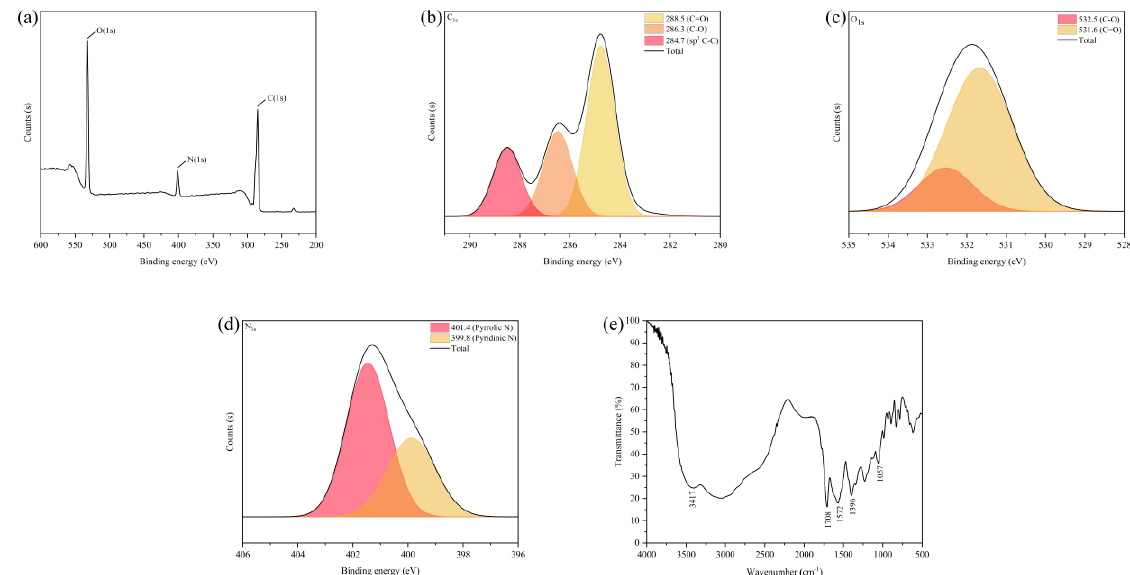
Figure 2. ( a ) XPS scanning spectrum of CDs. ( b ) C 1S , ( c ) O 1S , ( d ) N 1S XPS spectra of CDs. ( e ) FT-IR spectrum of CDs.